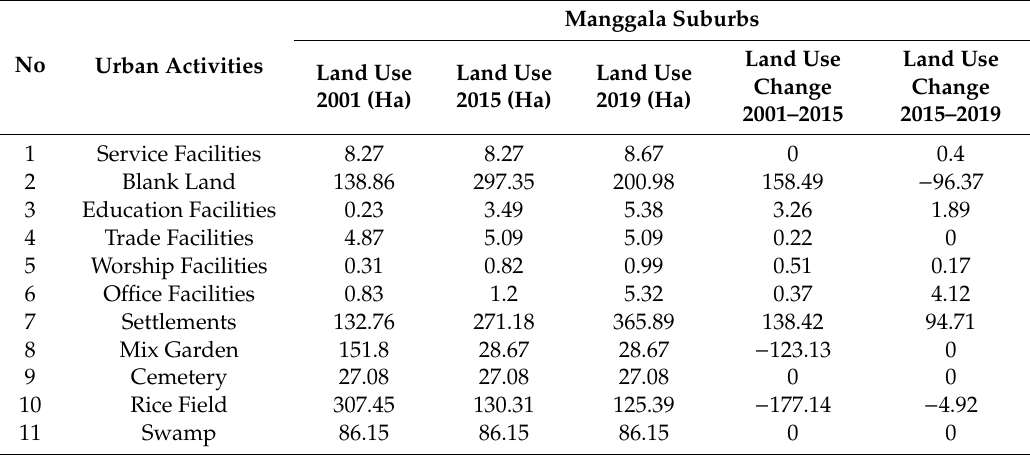
Figure 7. Change to Land Use in the Manggala Suburbs. Source: author elaboration, Map © 2001, 2015, 2019 Google. Table 2. Change to Land Use in the Hertaning-Samata